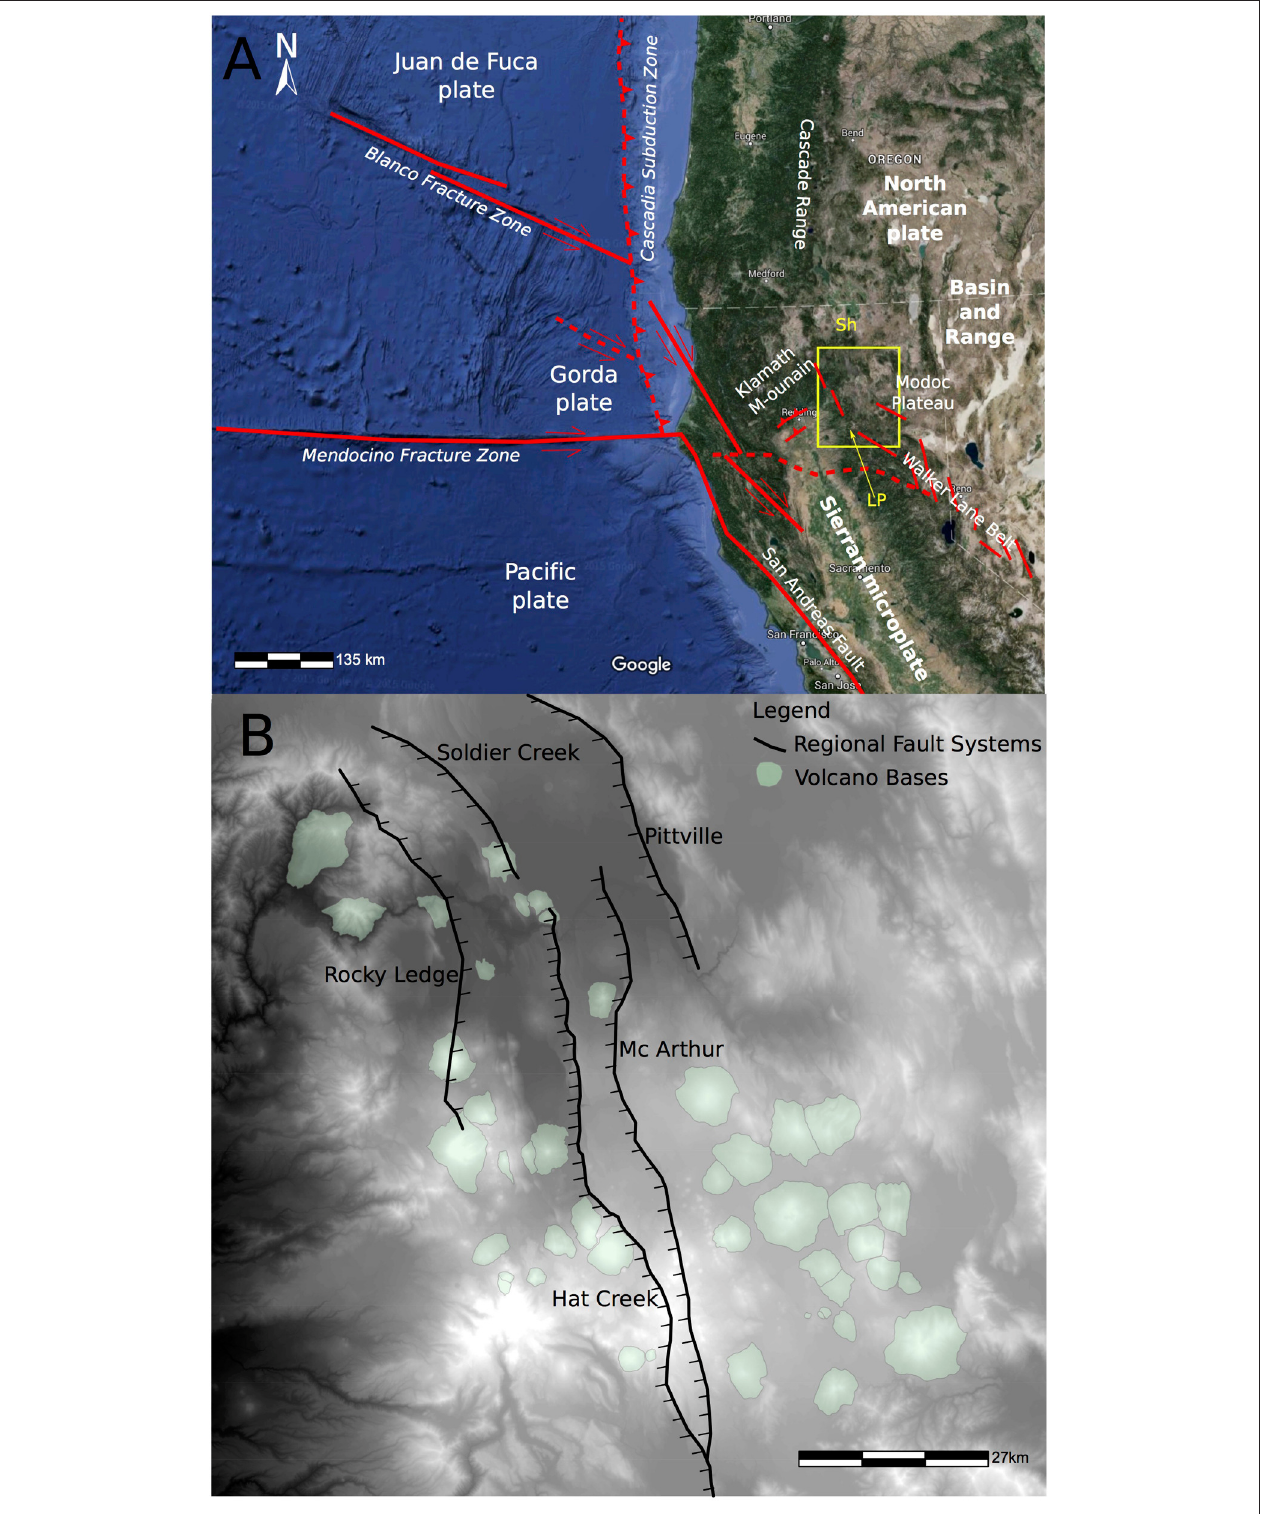
FIGURE 1 | (A) Regional tectonic setting of the eastern boundary of the Southern Cascades (Hat Creek Graben region), California, is dominated by the convergence of the Pacific, Juan de Fuca, Gorda, and North American Plates resulting in the formation of the Cascadia Subduction Zone and its associated Cascade Arc